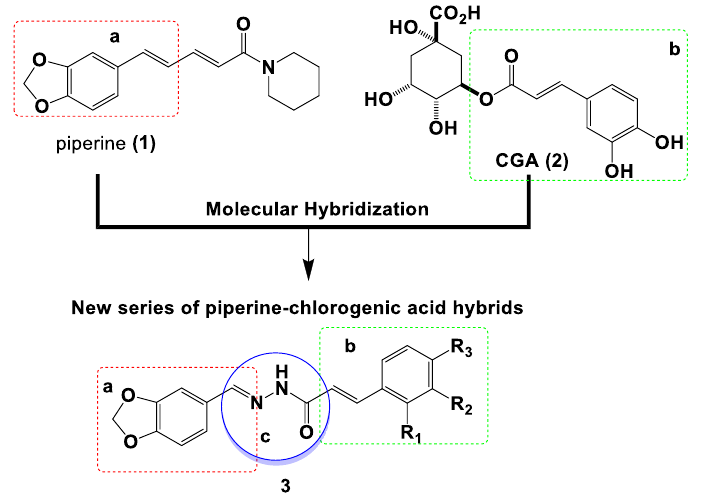
Figure 1. Design of new piperine–chlorogenic acid acylhydrazone hybrid series 3 by molecular hybridization of structural fragments from piperine ( 1 ) and chlorogenic acid ( 2 , CGA) connected by an acylhydrazone subunit. a conjugated benzo[d]1,3-dioxole moiety from the piperine ( 1 ); b cinnamoyl fragment from chlorogenic acid ( 2 ); c acylhydrazone spacer